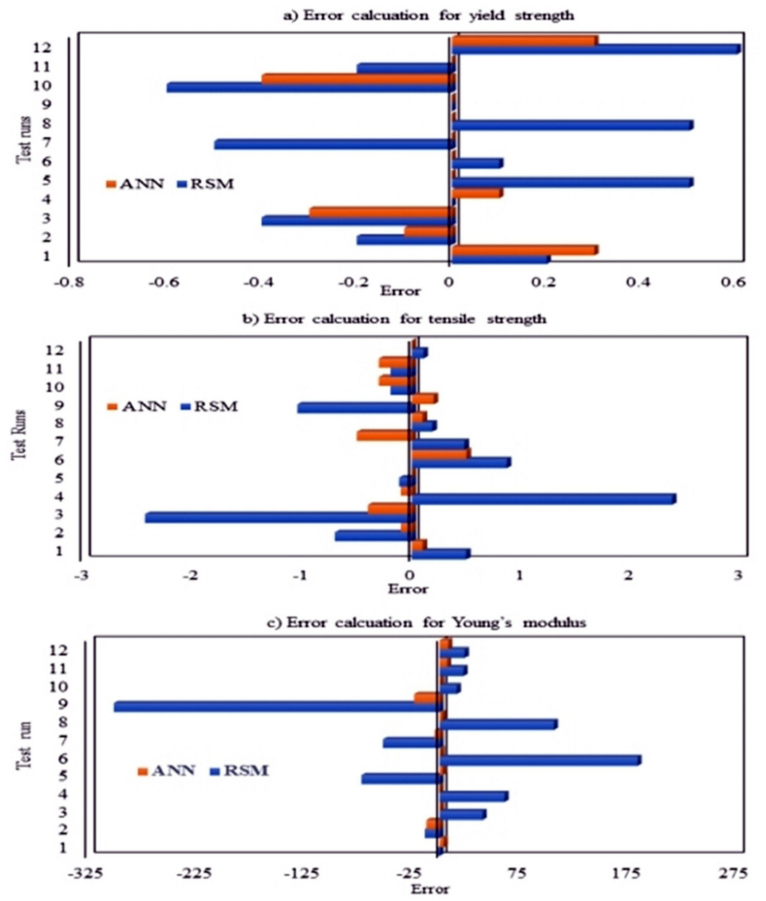
Figure 15. Bar charts representing the predicted errors of ( a ) yield strength; ( b ) fracture strength and ( c ) Young’s modulus of the developed nanocomposites by ANN and